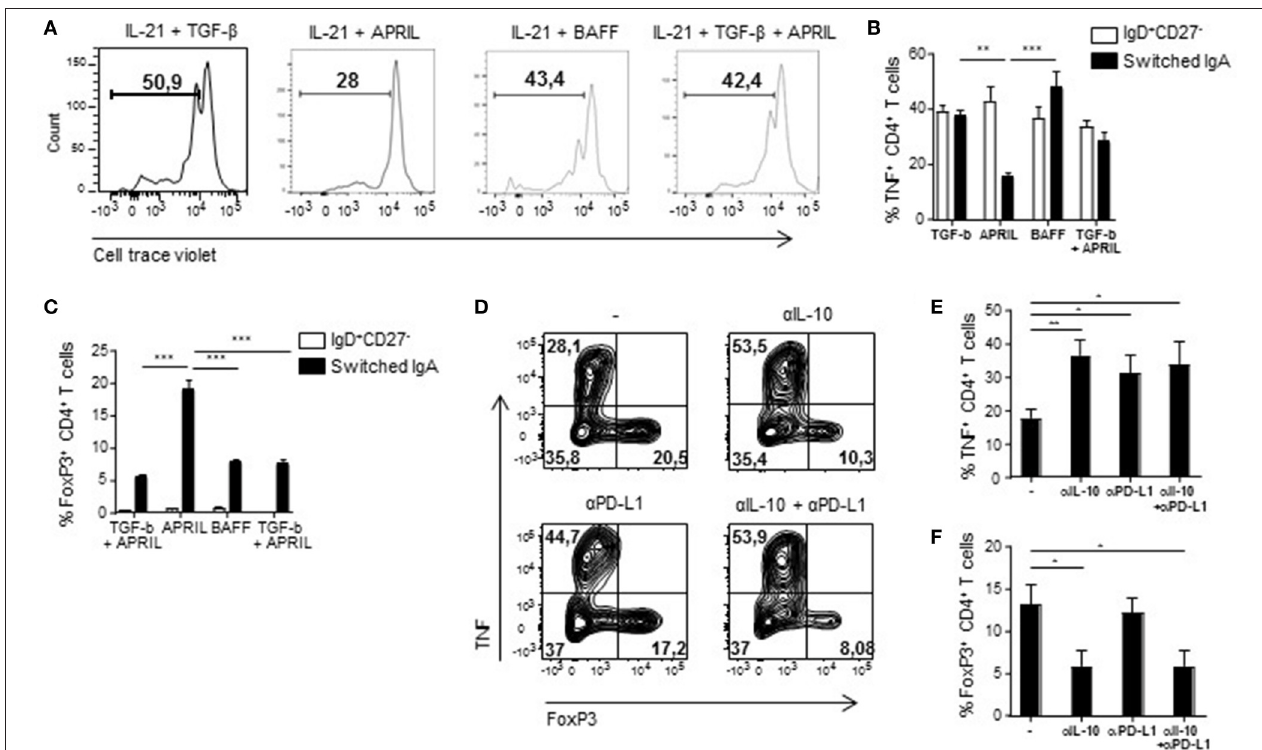
FIGURE 6 | APRIL-induced IgA + regulatory B cells suppress CD4 + T cell proliferation and TNF production, while stimulating the expansion of FoxP3 + CD4 + T cells. (A) After 5 days of co-culture of Bregs and autologous CD4 + T cells, proliferation of the CD4 + T cells was analyzed using a cell trace violet dye and flow cytometry. Representative histograms are shown. (B) TNF production by the CD4 + T cells was assessed after 3 days of co-culture using flow cytometry. Percentages of TNF + CD4 + T cells are depicted. (C) The frequency of regulatory FoxP3 + CD4 + T cells was analyzed after 3 days of co-culture using flow cytometry. (D–F) Neutralizing antibodies to IL-10 and PD-L1 were added to the co-cultures. After 3 days of co-culture of APRIL-induced IgA + Bregs and CD4 + T cells in the presence of neutralizing antibodies to IL-10, PD-L1, the combination or control medium, the frequencies of TNF + and FoxP3 + CD4 + T cells were assessed. (D) Representative dot plots of the frequencies of TNF + and FoxP3 + CD4 + T cells. (E,F) Quantification of the frequencies of TNF + (E) and FoxP3 + (F) CD4 + T cells induced by APRIL-driven regulatory IgA + B cells. (B–F) Mean ± SD are shown, n = 4. * P < 0.05, ** P < 0.01, and *** P < 0.001 (one-way ANOVA with Bonferroni multiple comparison